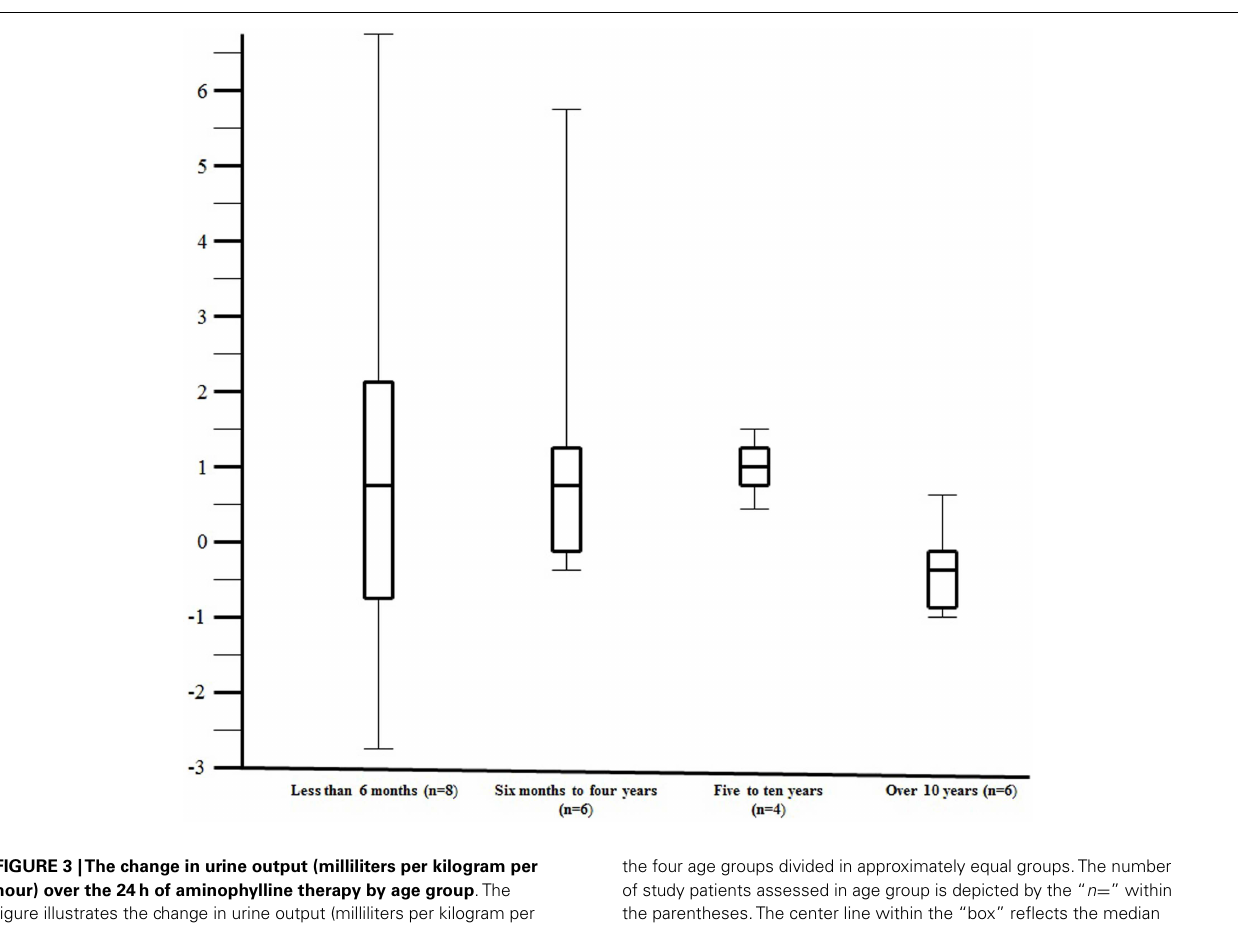
FIGURE 3 |The change in urine output (milliliters per kilogram per hour) over the 24h of aminophylline therapy by age group .The figure illustrates the change in urine output (milliliters per kilogram per hour) over the 24h of aminophylline therapy by age group.The change in urine output (milliliters per kilogram per hour) over the 24h of aminophylline therapy is plotted along the y -axis.The x -axis contains